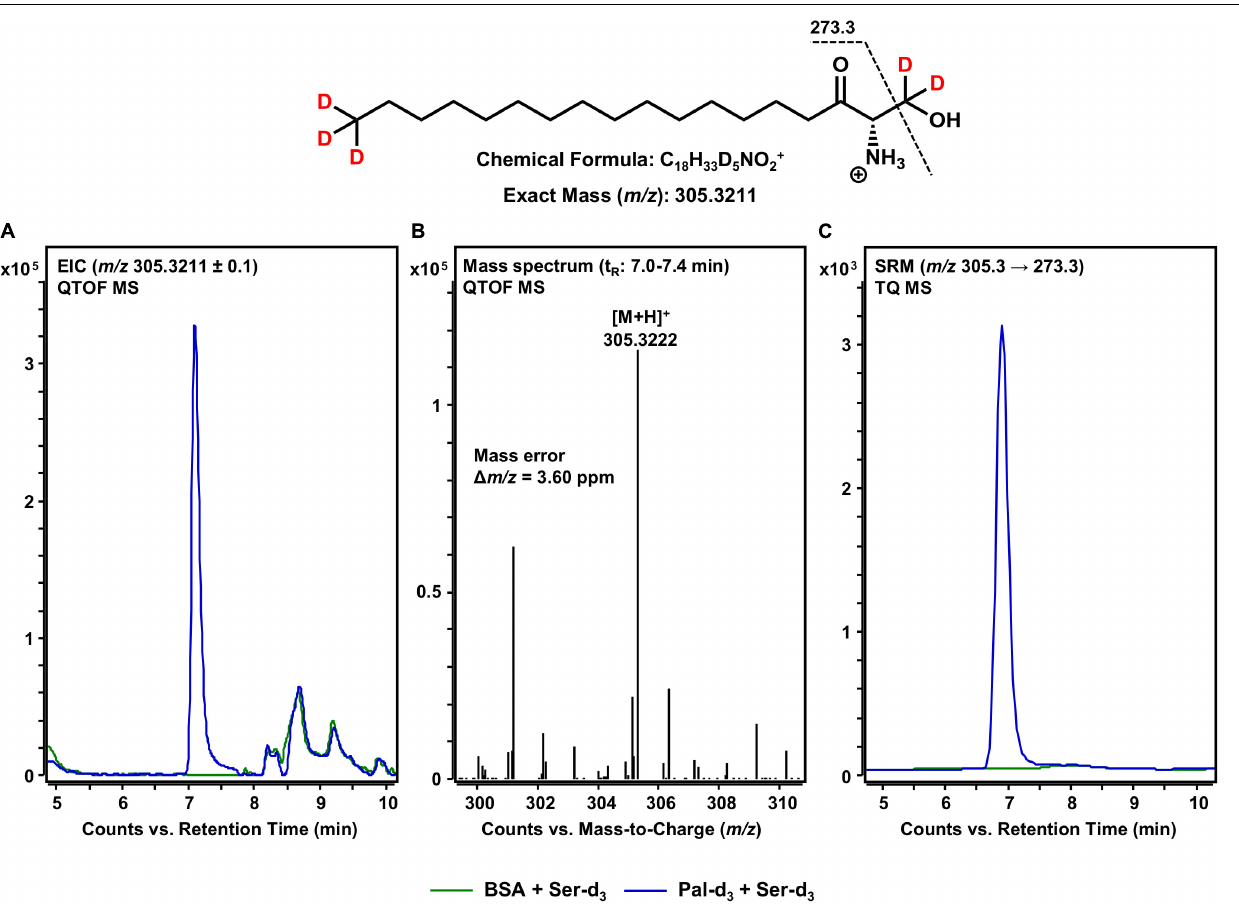
FIGURE 2 | SPT-catalyzed formation of 3KS-d 5 from the in vitro assay substrates palmitate-d 3 and L -serine-d 3 . (Top) Chemical structure, formula, and exact mass of the protonated molecular ion [M+H] + of 3KS-d 5 generated during electrospray ionization. Dashed black line represents the mass transition used for selected reaction monitoring (SRM). (A) Overlay of extracted ion chromatograms (EIC) of the microsomal de novo synthesis assay using palmitate-d 3 and serine-d 3 as substrates (blue) compared to the negative control omitting palmitate-d 3 (green). (B) Mass spectrum extracted from the EIC in the retention time window of eluting 3KS-d 5 with annotation of the molecular ion peak and the calculated mass error. (A,B) Analysis was conducted on a quadrupole time-of-flight mass spectrometer (QTOF MS). (C) Overlay of SRM analyses of assay (blue) compared to negative control sample (green) performed with a triple quadrupole mass spectrometer (TQ MS). t R , retention time. (A) In the t R range of 8–10 min, relatively abundant unidentified matrix components ( m/z : 305.2211 ≤ × ≤ 305.4211) eluted from both the assay and negative control samples. (C) Concordant matrix signals were diminished, with increased specificity achieved by analyzing compound-specific